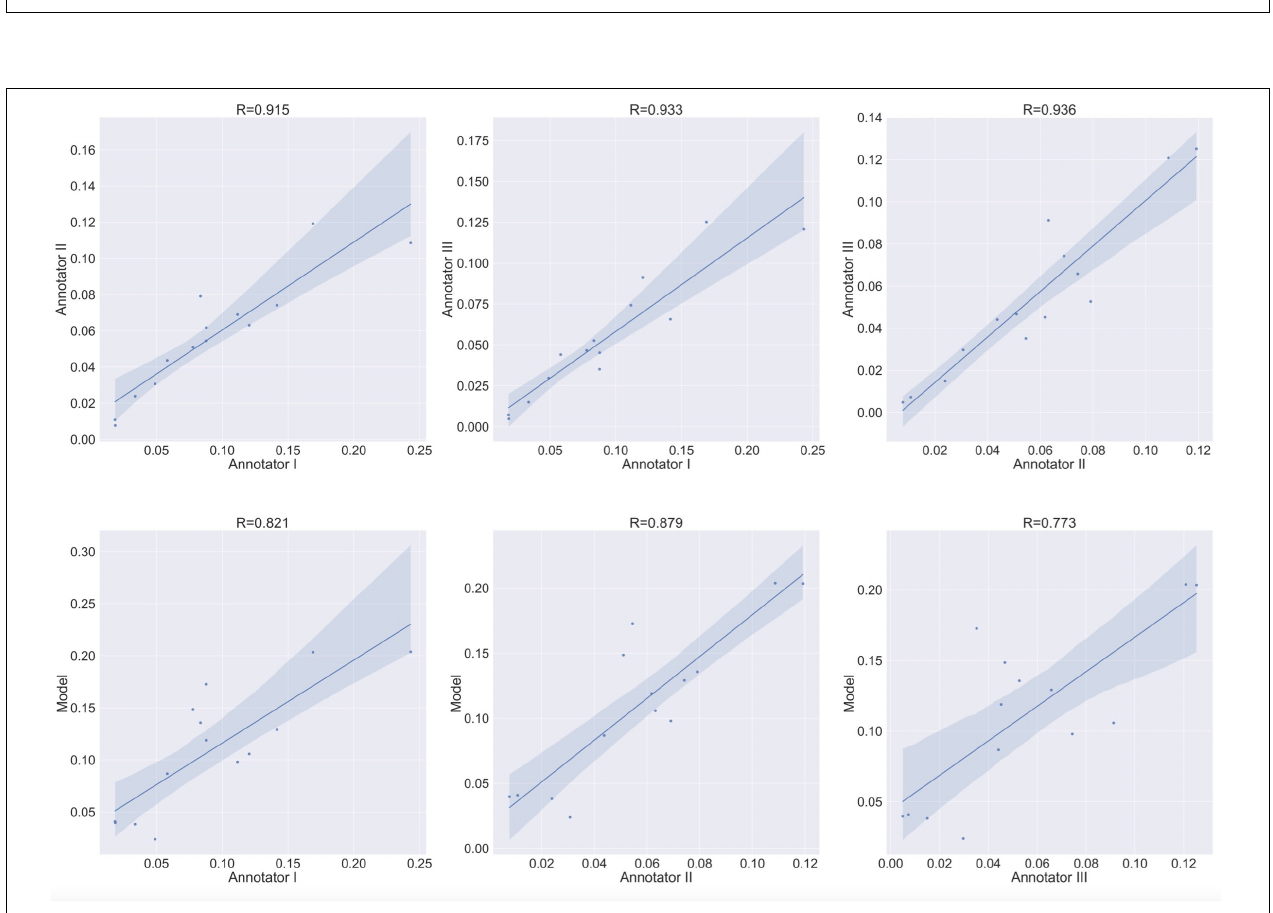
FIGURE 8 | SSD implementation using bounding boxes. Left: patch with polygons annotated by a human annotator; Right: patch after transforming the polygons to the tightest square surrounding a polygon. Blue bounding boxes correspond to type I osteoclasts and red bounding boxes correspond to type II osteoclasts.